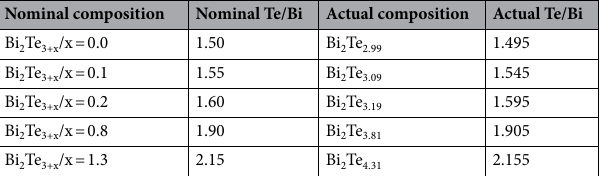
Table 3. The compositions and Te/Bi ratio of the annealed Bi–Te thin films.